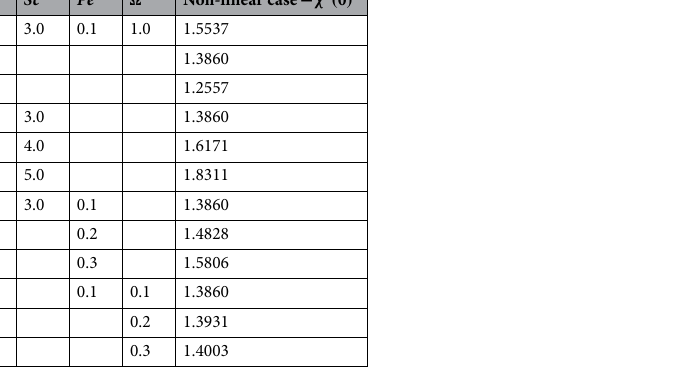
Table 5. Results for motile density number